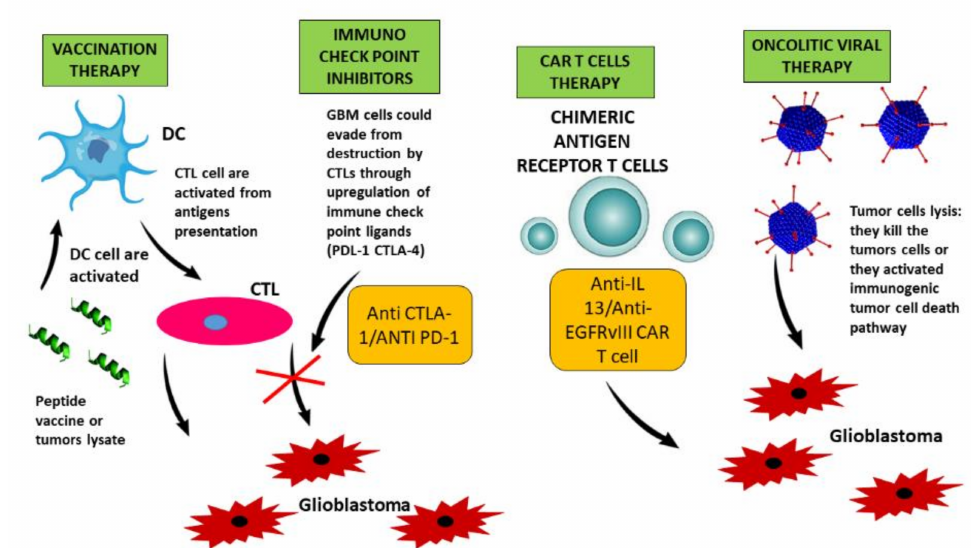
Figure 3. Glioblastoma vaccine consists of the presentation of glioblastoma-associated antigens, peptides or epitopes (derived from tumor lysate to T cells). The tumor cells could evade the destruction by CTLs through the increase of immune checkpoint ligands. The use of checkpoint inhibitors could prevent this interaction. The presence on the glioblastoma cell surface of IL-13 and EGFR receptors, which are presented independently of MHC class I, makes it possible to develop modified CAR T cells. Oncolytic viral therapy uses a virus that can activate the immunogenic cancer cell death pathway or kill the tumor cell